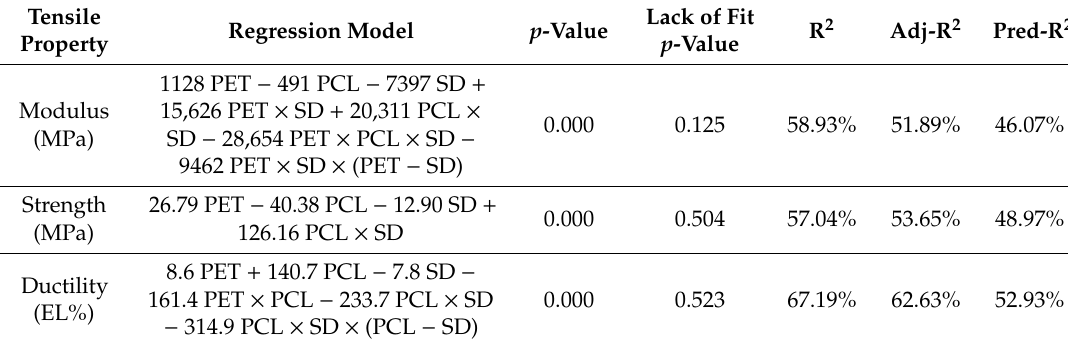
Table 3. E ff ects of components’ content on rPET WPC tensile